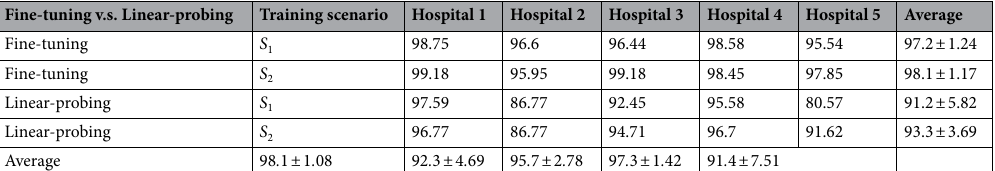
Fine-tuning v.s.